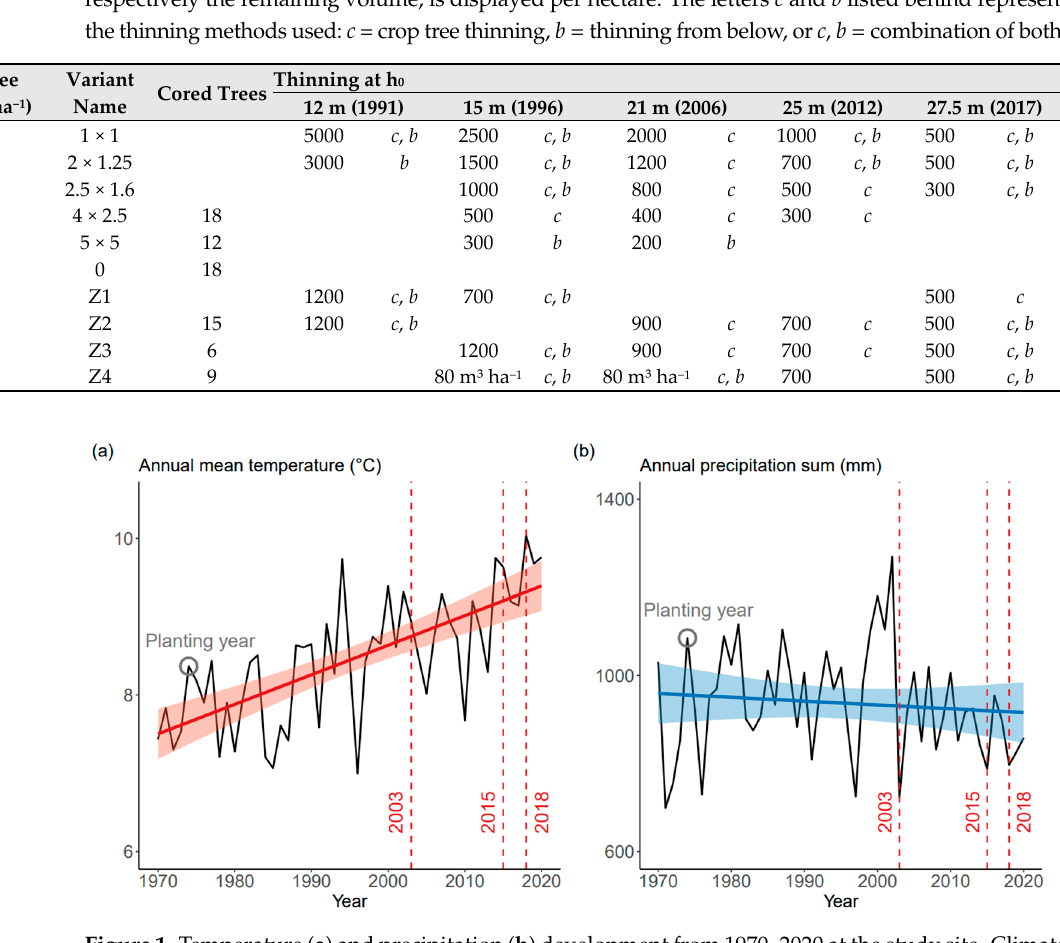
Figure 2. Study design of Fürstenfeldbruck 612 (FFB 612). The trial includes ten different spacing– thinning combinations in two blocks, comprising 21 equally sized, rectangular plots, each bordered by a buffer zone. Plots that are surrounded by thin lines differ regarding their initial spacing (spac- ing trial; 1.0 m × 1.0 m, 1.25 m × 2.0 m, 1.6 m × 2.5 m, 2.5 m × 4.0 m, 5.0 m × 5.0 m), whereas bold framed plots vary only in their thinning regime (thinning trial), having an initial spacing of 1.6 m × 2.5 m. The buffer zone was consistently treated similarly to the neighboring plots.